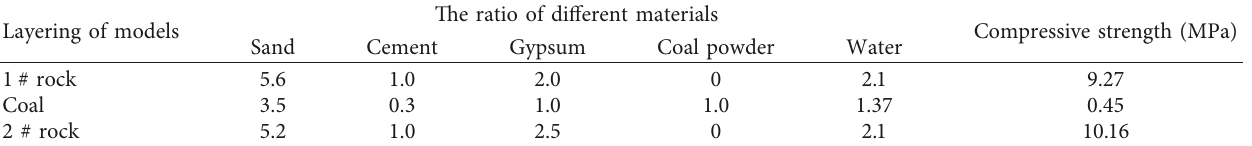
Table 1: Model-making